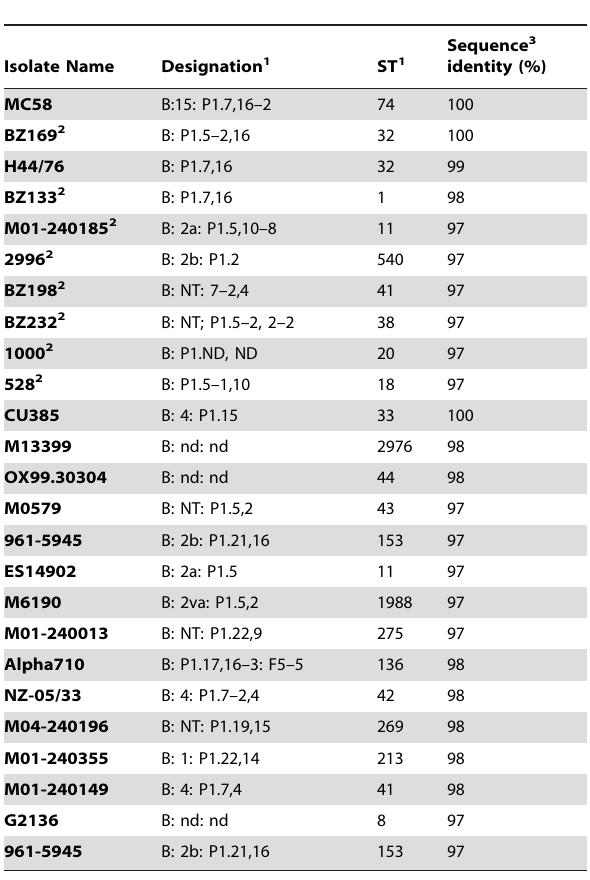
Table 6. Comparison of amino acid sequence between NMB0390 (752 aa) and its homologues from meningococcal